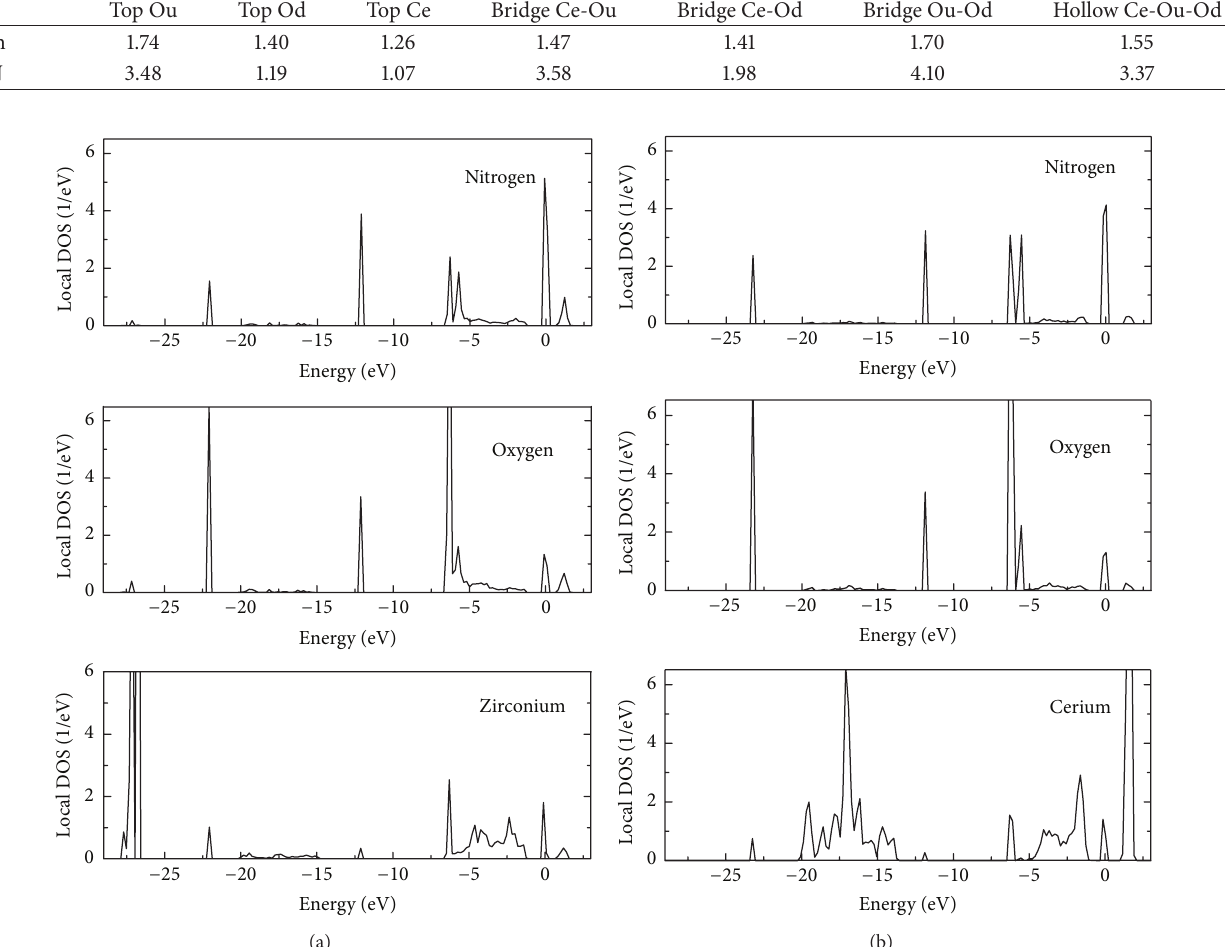
Table 3: Adsorption energy (in eV) of In and N atoms on Ce-segregated CeSZ (111) surfaces. Adatom